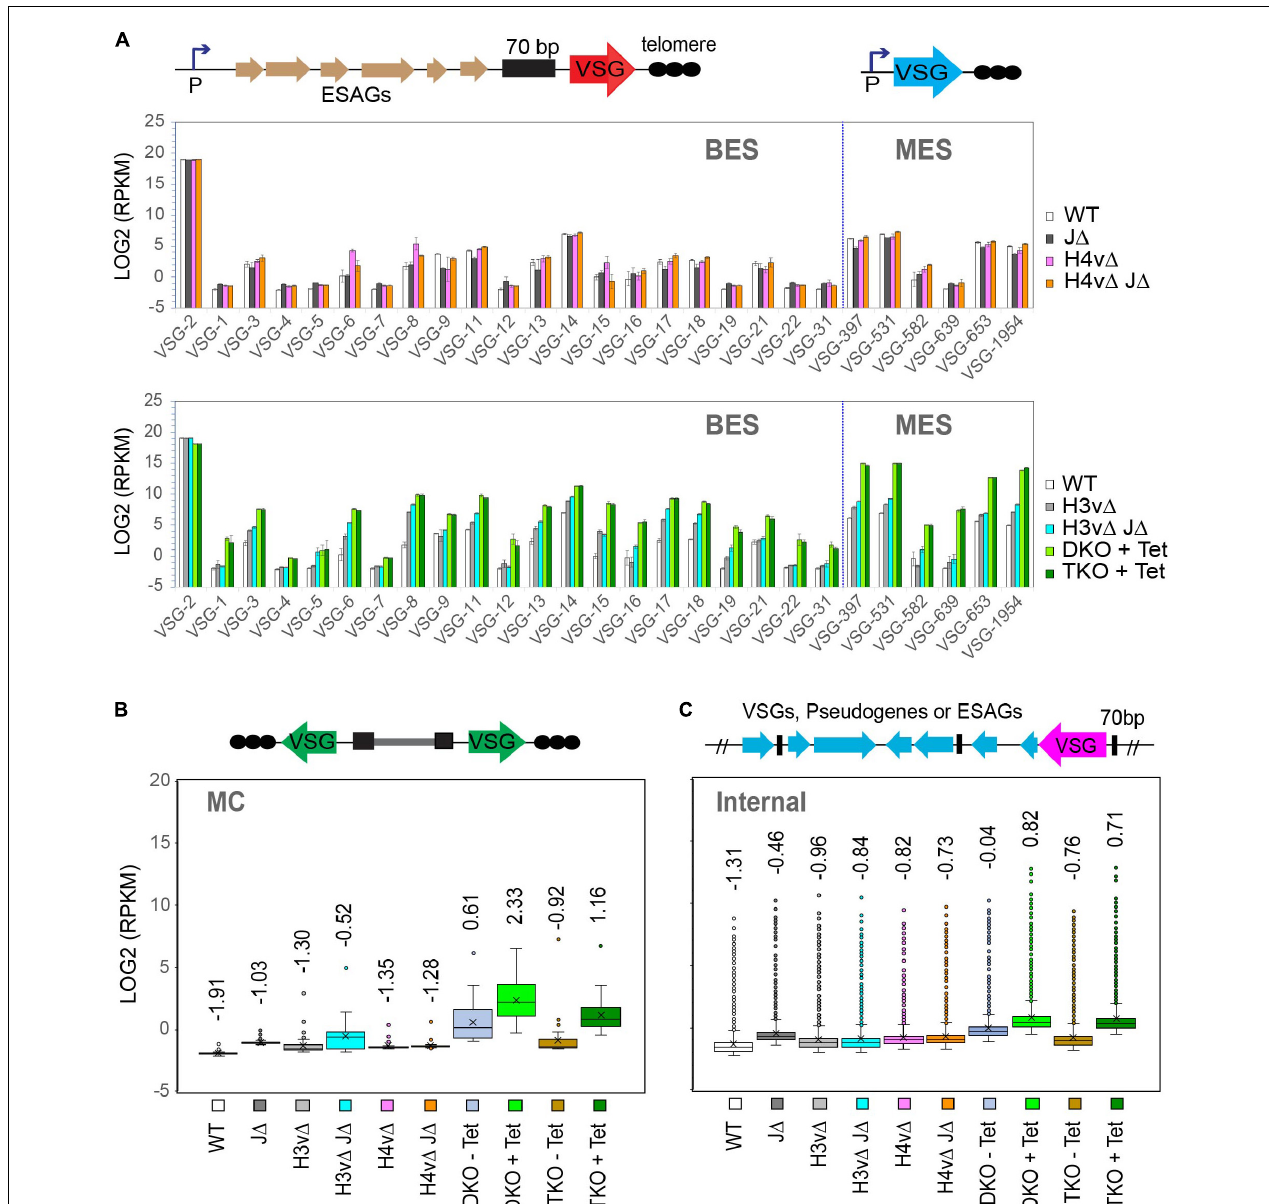
FIGURE 4 | TTS chromatin marks are requisite for variant surface glycoprotein (VSG) transcription in a synergistic manner. VSG RNA levels in WT and KO mutants were analyzed by rRNA-depleted stranded RNA-seq. RNA-seq reads were aligned to the VSGnome database (Cross et al., 2014), and LOG 2 (RPKM) values were obtained for each VSG in wild-type and KO mutants. (A) Bar graphs comparing WT and KO mutants for bloodstream-form expression site (BES) and metacyclic VSG expression site (MES) VSG expression levels. Mutants are grouped by the loss of VSG silencing phenotype: mutants that showed no change (top; including J (cid:49) , H4v (cid:49) , and H4v (cid:49) J (cid:49) ) and mutants that increased the expression of silent VSGs (bottom; including H3v (cid:49) , H3v (cid:49) J (cid:49) , DKO + Tet, and TKO + Tet). Error bars indicate standard deviation between three replicates. Diagrams of BES and MES are shown. (B) Box plot comparing WT and KO mutants for minichromosomal (MC) VSG expression levels. (C) Box plot comparing WT and KO mutants for chromosome internal VSG expression levels. Statistical analyses are summarized in Supplementary Table 7